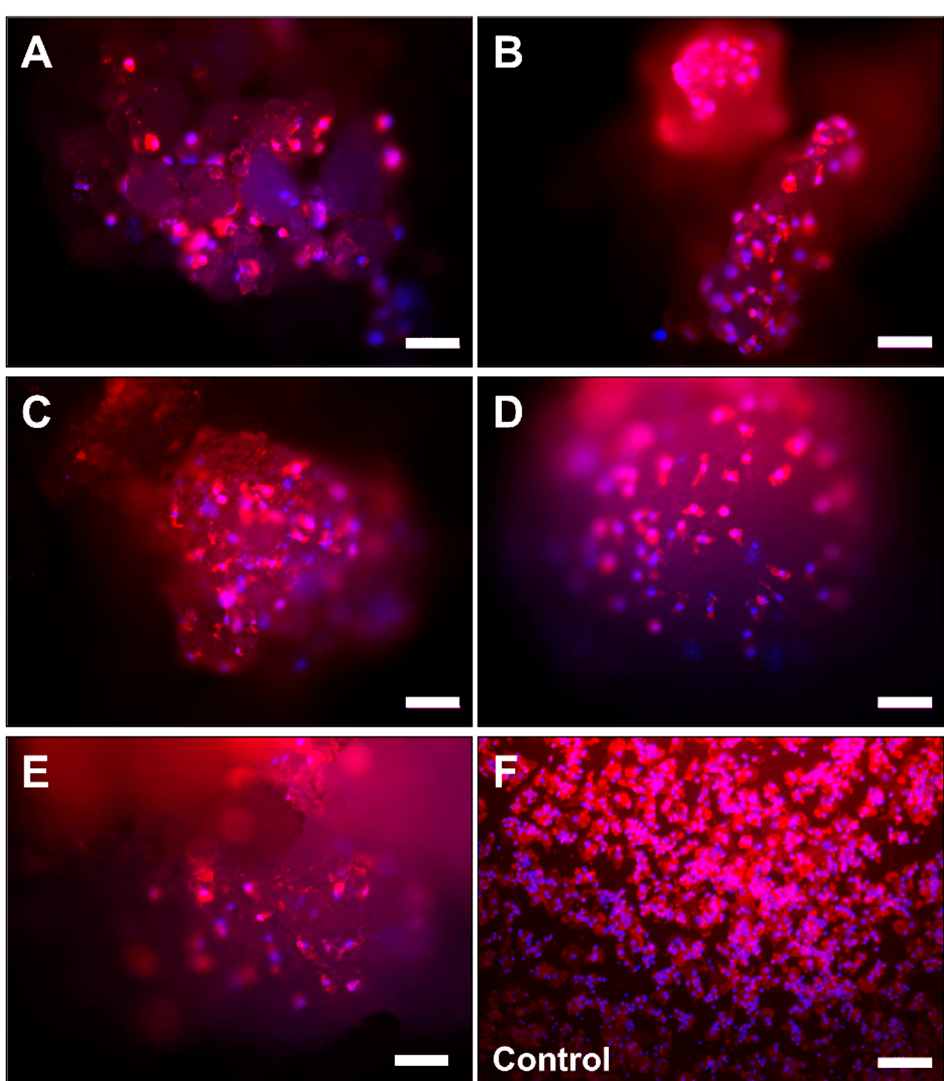
Figure 3. Microscopic images of the primary monocytes/macrophages on the surfaces of the